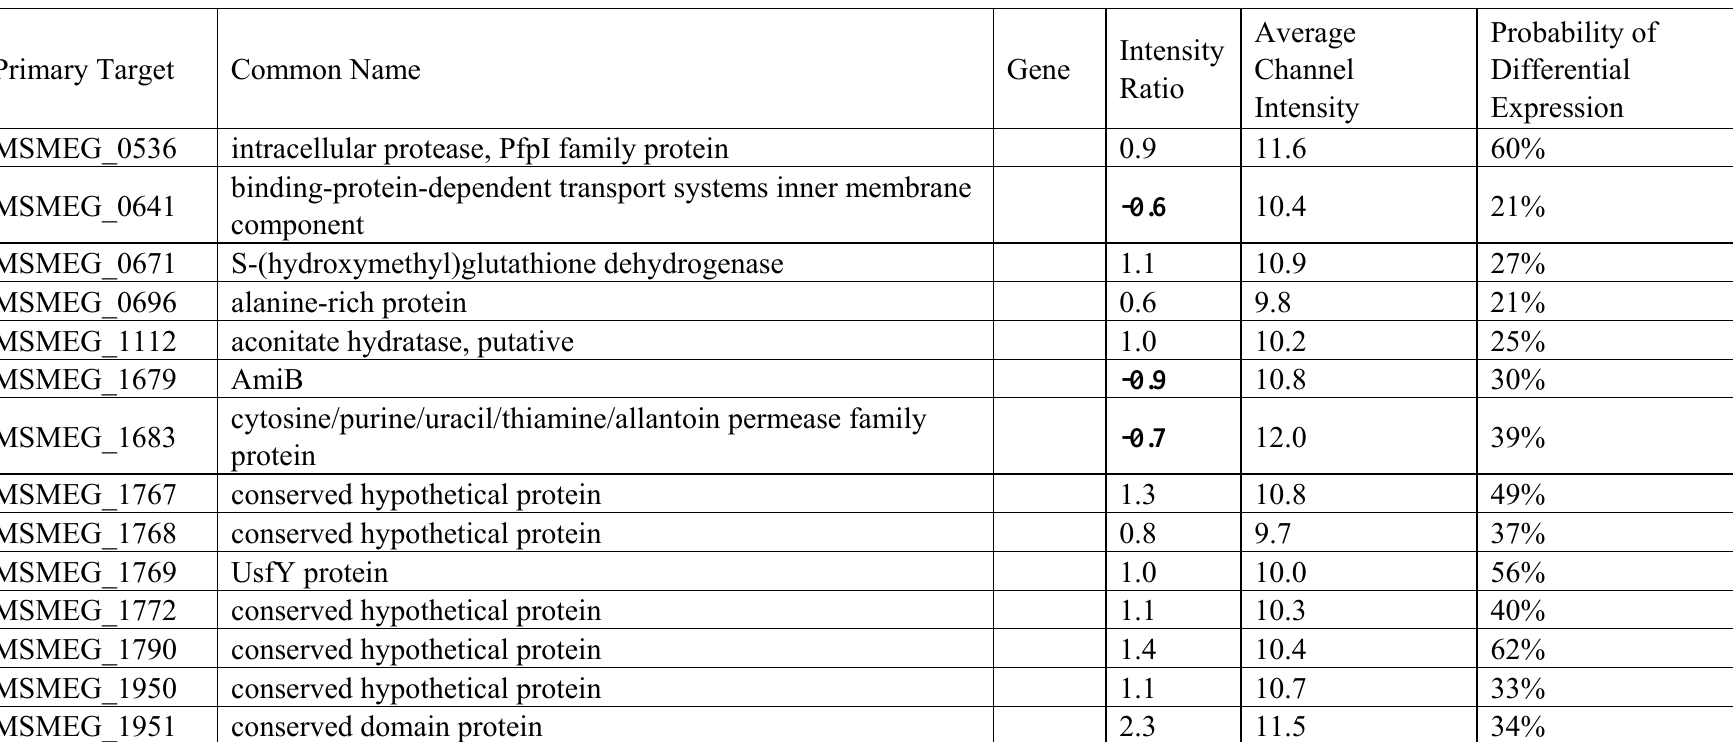
Appendix Table 6. Stationary phase differential gene expression in multiply cycled bacteria versus non-previously spray dried bacteria (positive expression indicates stationary